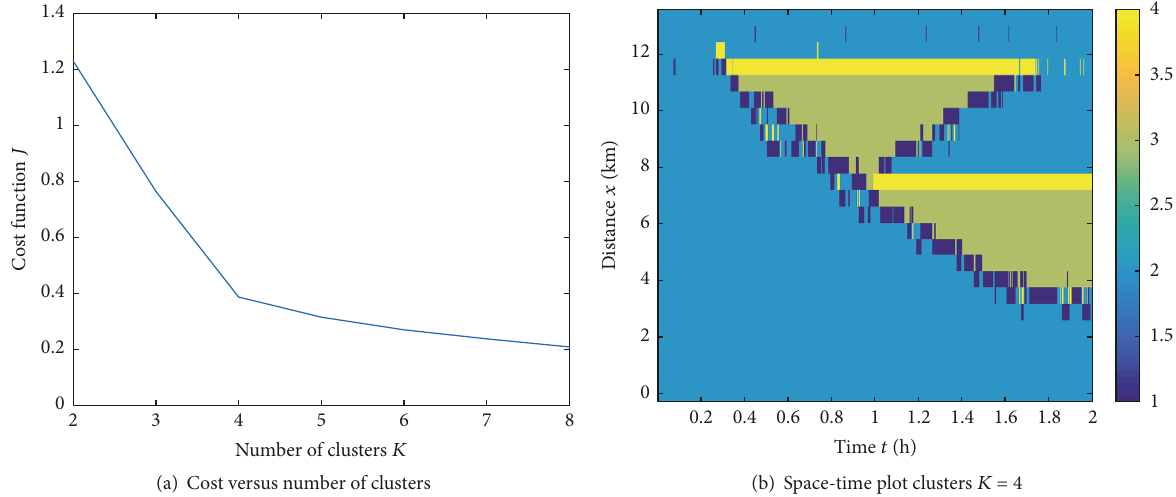
Figure 2: Cost function dependent on the number of clusters and visualization of the cluster in the space-time domain for the optimal number of clusters 𝐾 = 4 . Table 1: Interpretation of the four clusters based on the cluster centroids and the error distribution characteristics for probe and loop-detector data-based estimates per